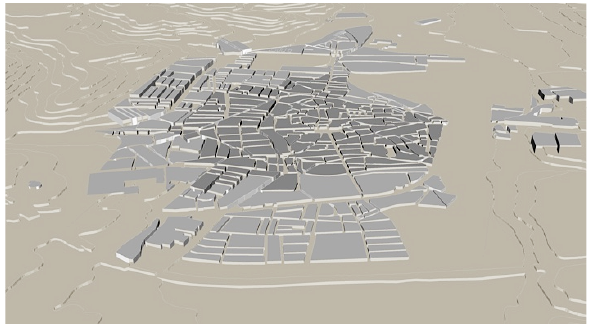
Figure 5. Urban evolution of the city of Ecija. The municipal border in 1900 is marked in dark grey and the current limit in light grey (The authors, 2018)